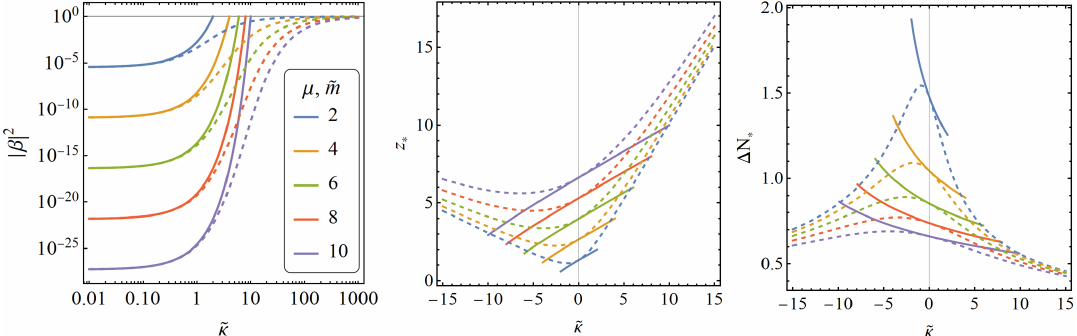
Figure 9 . The production histories in exact dS. Left panel: production amount as a function of the dimensionless chemical potential for different particle masses. Middle panel: the z -domain production time dependence on chemical potential and mass. Right panel: production width mea- sured in e-folding numbers. In all three plots, solid lines represent spin-1 bosons while dashed lines represent spin-1/2 fermions. Particles with different masses are distinguished by the colors of the lines according to the legend in the left panel. For bosons, we limit the range of chemical potential to be smaller than the mass, so that no tachyonic instability is induced. For fermions, the chemical potential is not restricted and we allow it to take arbitrarily large